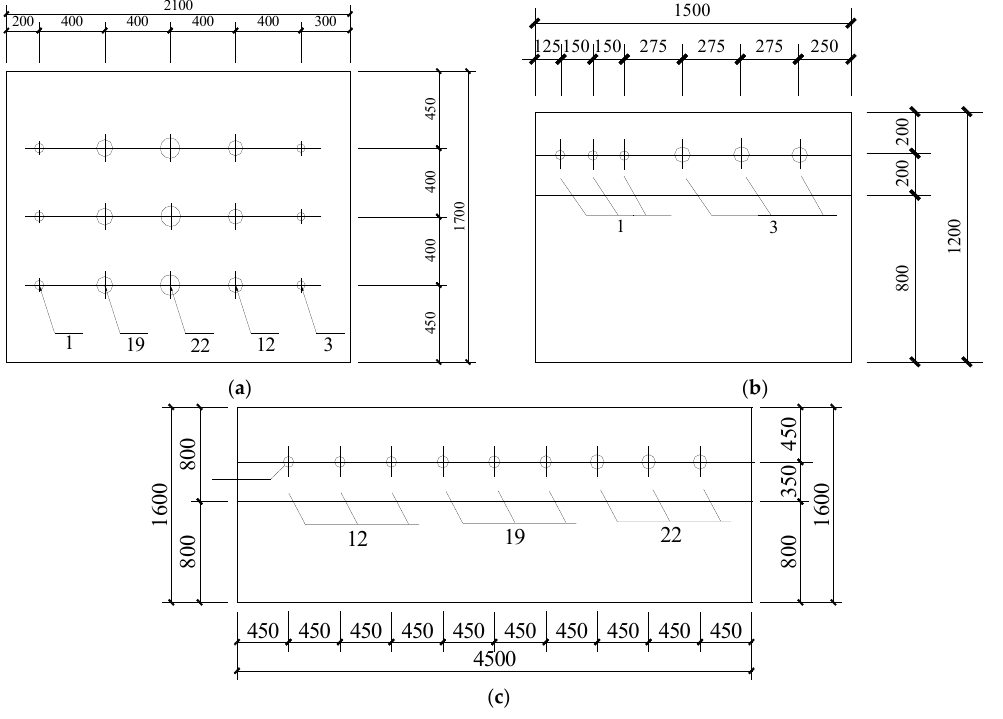
Figure 3. Arrangement for the duct based on the project of Malinghe Bridge: ( a ) straight tendons with 1, 3, 12, 19 and 22 wires; ( b ) curve tendons with 1 and 3 wires; and ( c ) curve tendons with 12, 19 and 22 wires (unit: mm). Table 4. Details of the specimen.